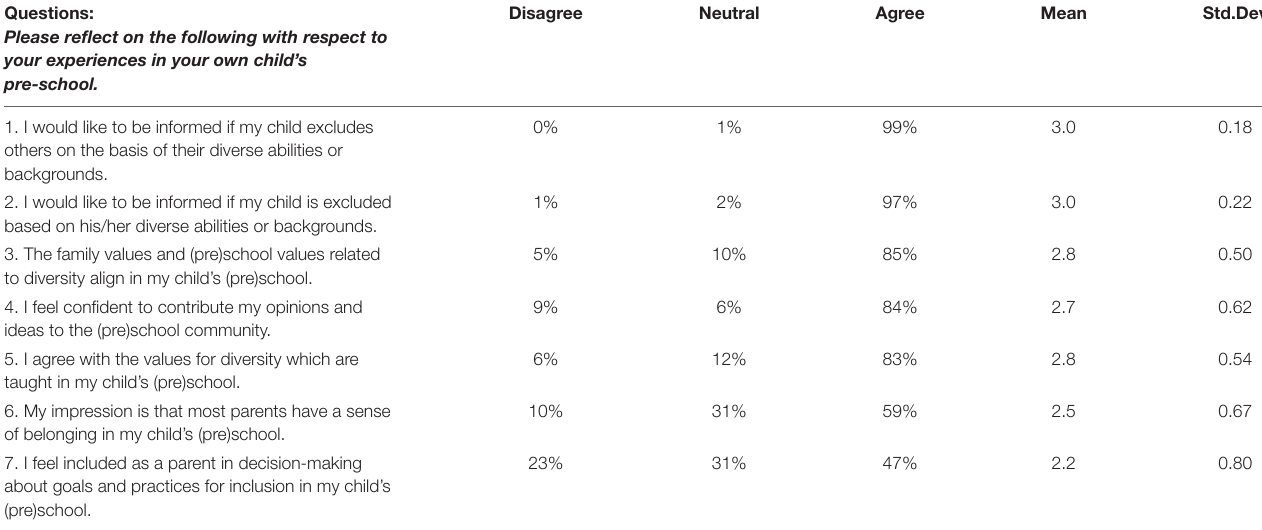
TABLE 7 | Scale 2: Parents’ sense of belonging and participation in pre-school. Questions: Please reflect on the following with respect to your own child’s pre-school.